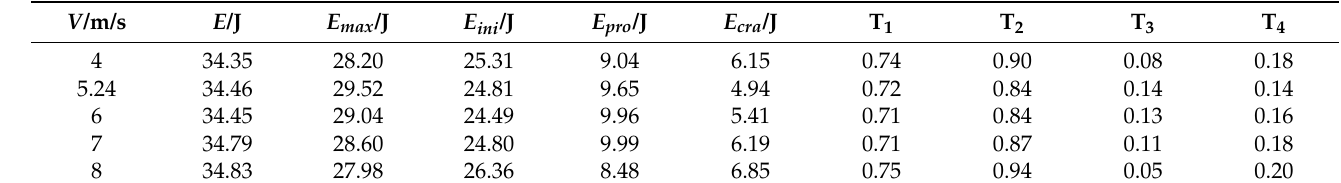
Figure 17. Characteristic time and load at different striker velocities. According to the simulation results, the energy of each part of the sample under different hammer velocities was obtained, and the ratio of each energy component to the total energy was calculated, as shown in Table 6 and plotted in Figure 18. It can be seen that E , E ini , E pro , E cra , and E max did not change significantly with the increase in strike speed. The rates of change of E max and E ini were within 6%. The change in E was within 1%. Under different hammer velocities, the changes of T 2 , and T 4 , were not significant. Table 6. Characteristic energies and corresponding ratios at different striker velocities.